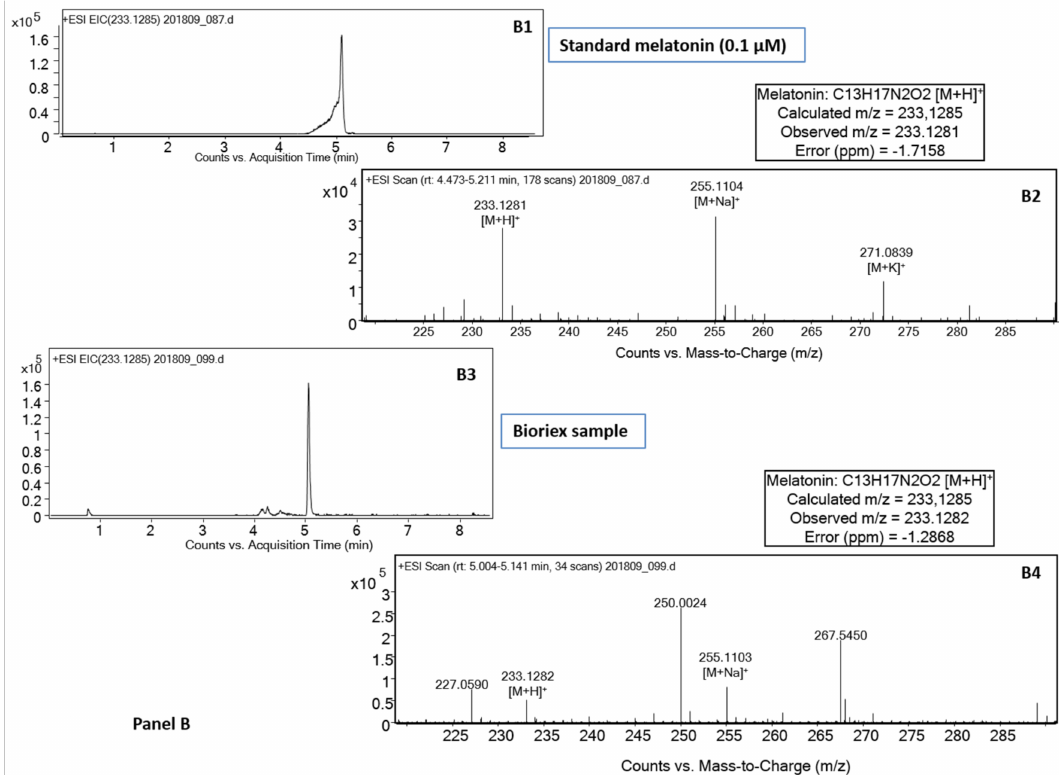
Figure 2. Panel A . Representative chromatograms of standard melatonin ( A1 ) and Bioriex sample ( A2 ) with liquid chromatography and fluorescence detection. Fluorescence detection was programmed at λ exc of 280 nm and λ emi of 350 nm. The melatonin peak has a retention time of 6.5 min. The excitation spectrum was measured with emission at 350 nm and the emission spectrum with excitation at 280 nm, using an in-line spectral analysis (stopped-flow) in standard melatonin ( A3 ) and Bioriex sample ( A4 ). Panel B . Representative chromatograms and mass spectra of standard melatonin, HM and Bioriex samples using liquid chromatography with time-of-flight / mass spectrometry (LC-QTOF / MS). ( B1 ): Extracted ion chromatogram (EIC) at m / z 233.13000 of a standard solution of melatonin. ( B2 ): Accurate mass spectra of standard melatonin solution showing di ff erent derivates of the base peak ion with the mass data analysis of protonated [M + H] + . ( B3 ): EIC as in B1 of Bioriex sample. ( B4 ): Protonated base peak ion of melatonin in Bioriex sample and their corresponding accurate mass